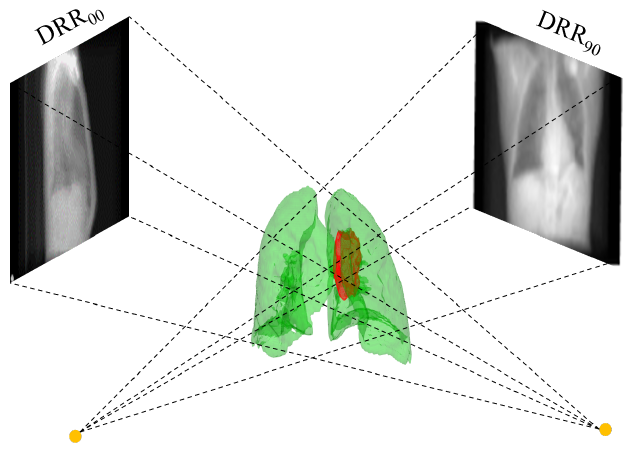
Figure 3. Schematic diagram of DRR image